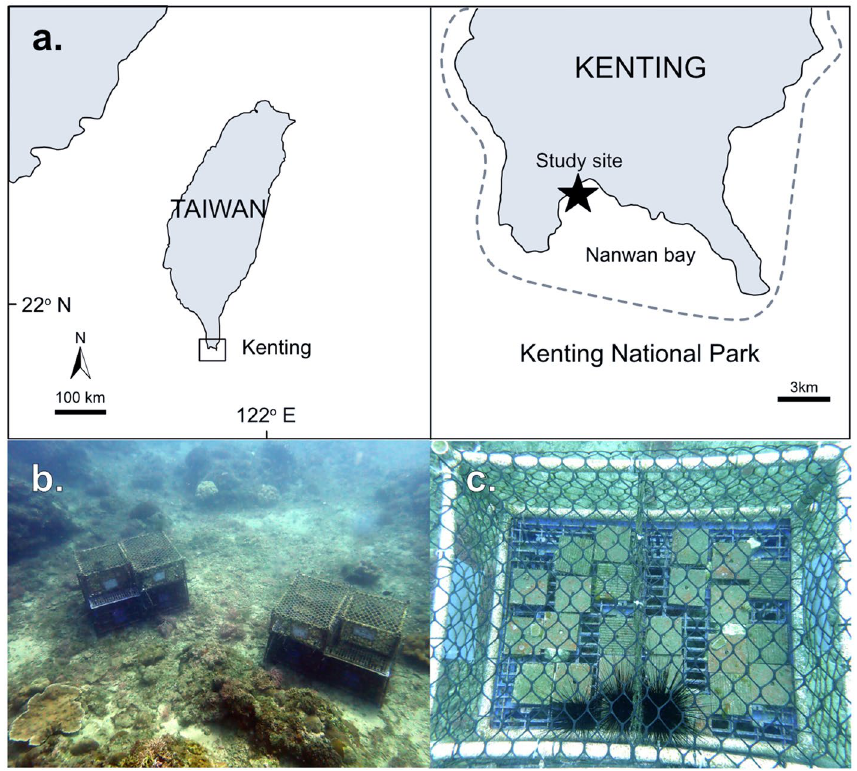
Figure 1. ( a ) Study location of the inclusion cage experiment at Nanwan bay, Kenting, Southern Taiwan. The area enclosed by the dashed line indicates Kenting National Park. The map was created using the package, maps ver. 3.3.0 with the software, R ver. 3.6.1 (https ://www.rdocu menta tion.org/packa ges/maps/versi ons/3.3.0). ( b , c ) Image of the inclusion cage experiment: ( b ) two of the five experimental cage groups, each consisting of three cages for three D. savignyi density conditions on the top of plastic container base; ( c ) close-up of two cages with 8 indiv. m −2 (right) and 16 indiv. m −2 conditions (left) of D. savignyi. Each cage had 12 experimental terracotta plates (10 cm × 10 cm) fixed on the mesh